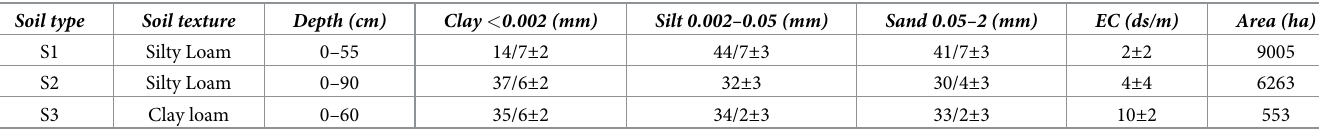
Table 1. Soil physical properties of three major soil types in the case study area.